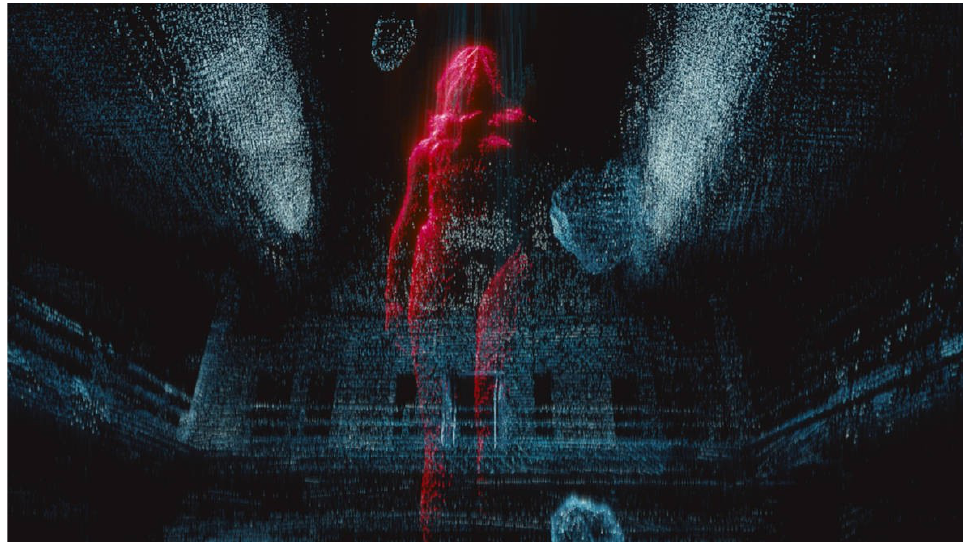
Figure 2. Alt Cunningham in